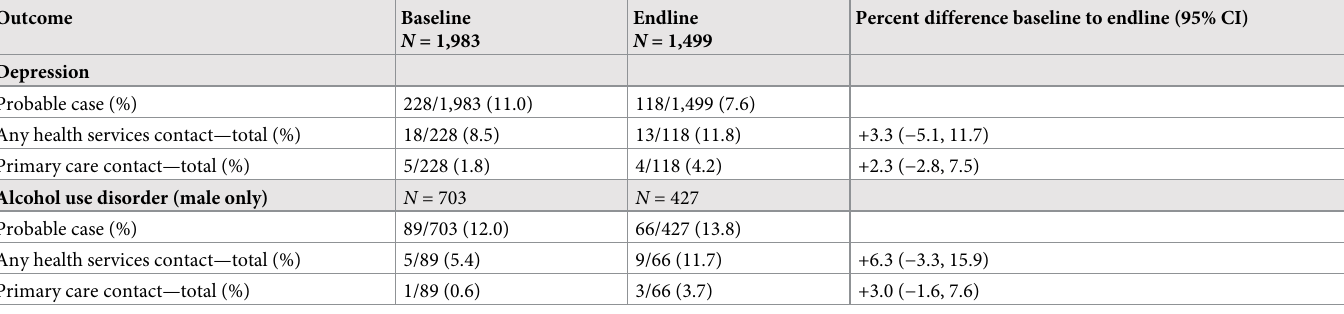
Table 4. Contact with a health worker for depression or for alcohol use disorder among adult residents based on 12-month recall, Chitwan District, Nepal, 2013– 2017. Outcome